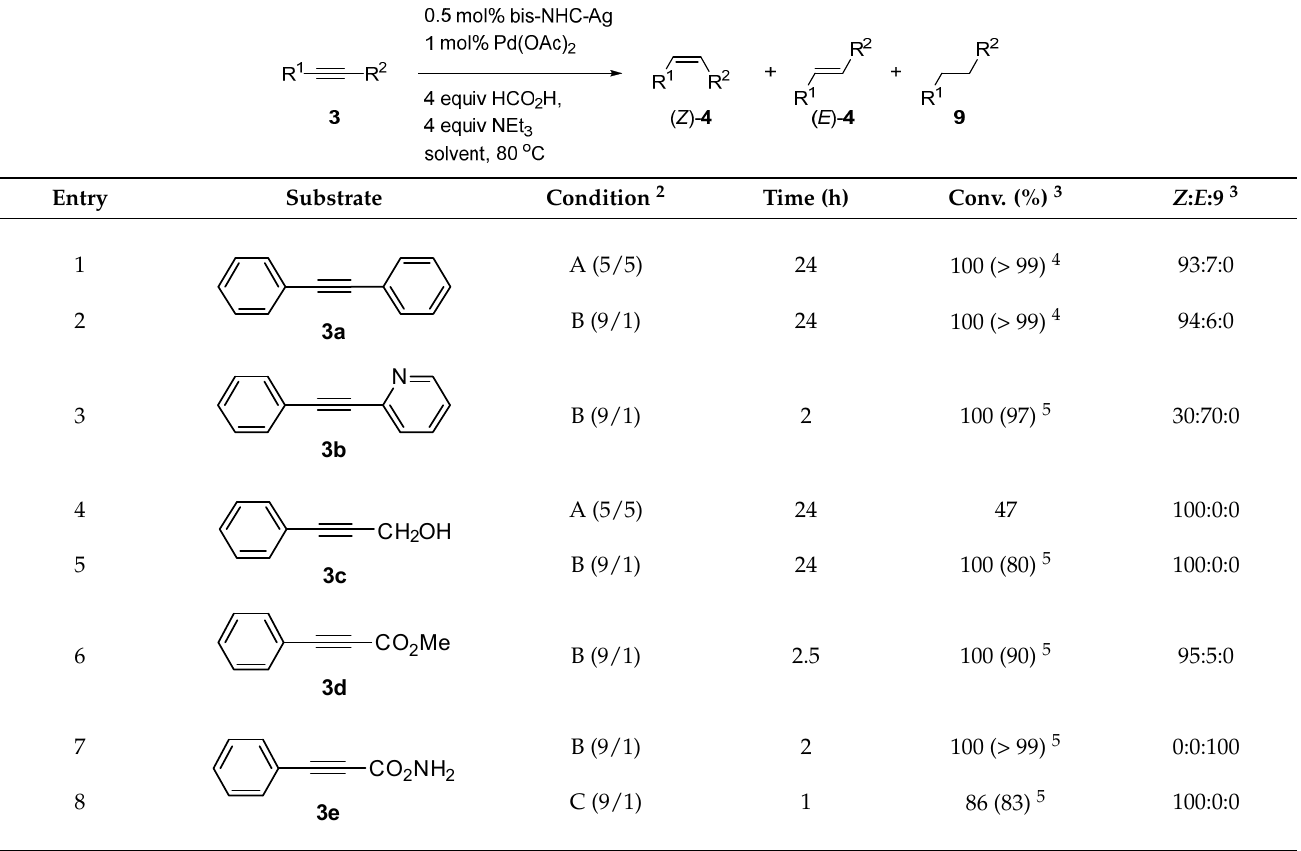
Table 4. Stereoselectivity studies for bis -NHC–Ag / Pd(OAc) 2 catalytic system catalyzed transfer hydrogenation of internal alkynes in aqueous media 1 . .